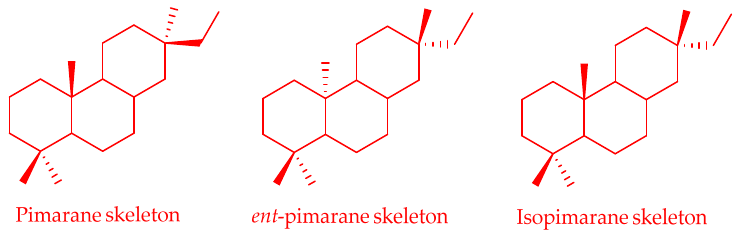
Figure 65. Skeleton of pimarane